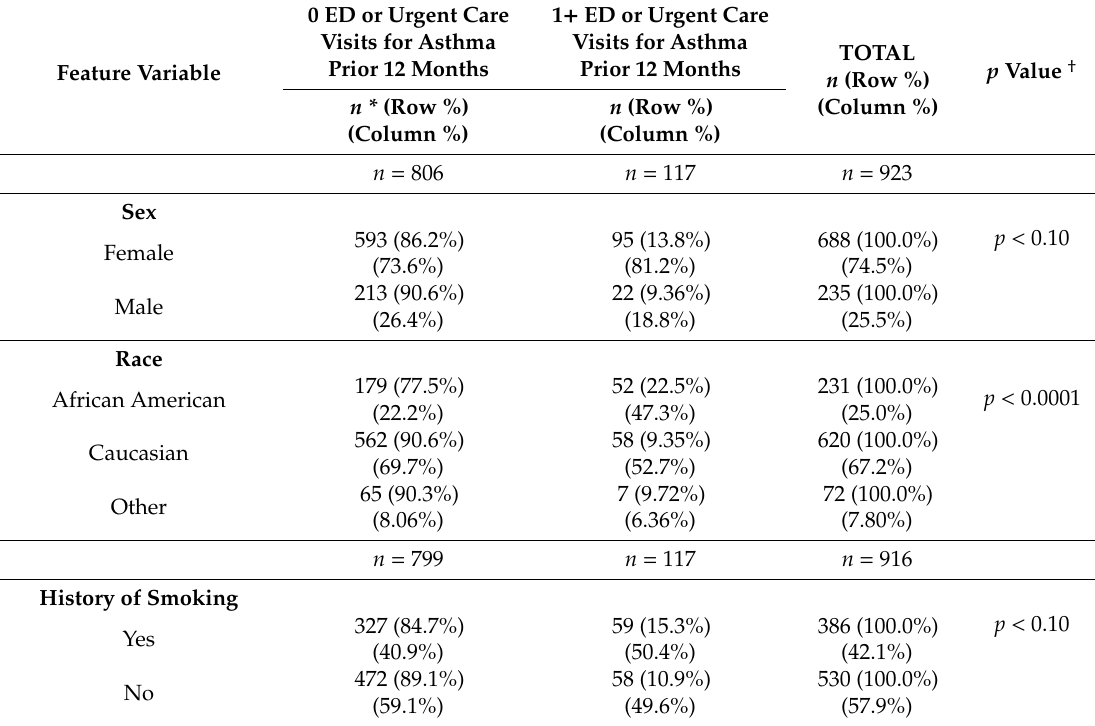
Table 2. EPR data on a subset of participants with a self-report of asthma, integrated at the participant-level with data derived from the Translator Exposures